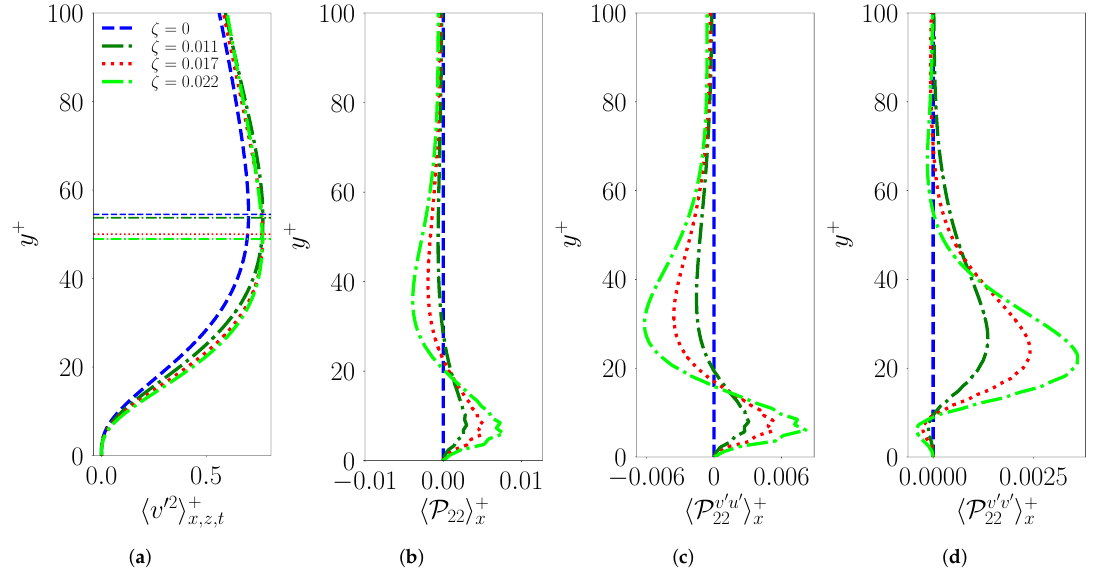
+ P 22 x . (cid:104) (cid:105) + + u (cid:48) v (cid:48) P u (cid:48) u (cid:48) x and ( d ) (cid:104) P x . 22 (cid:105) 22 (cid:105) (cid:104)